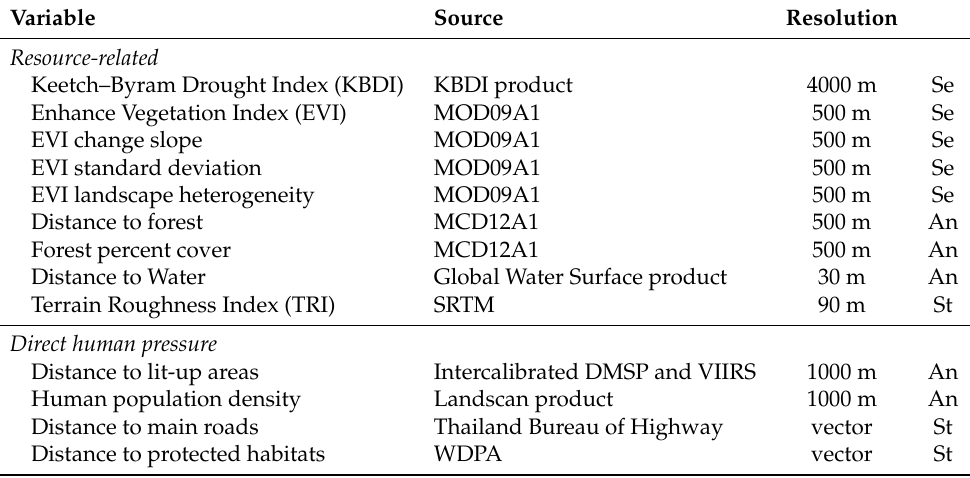
Table 1. List of predictor variables including data source, spatial resolution, and temporal scale in which data was prepared (temporal scale: An—Annual, Se—Seasonal,